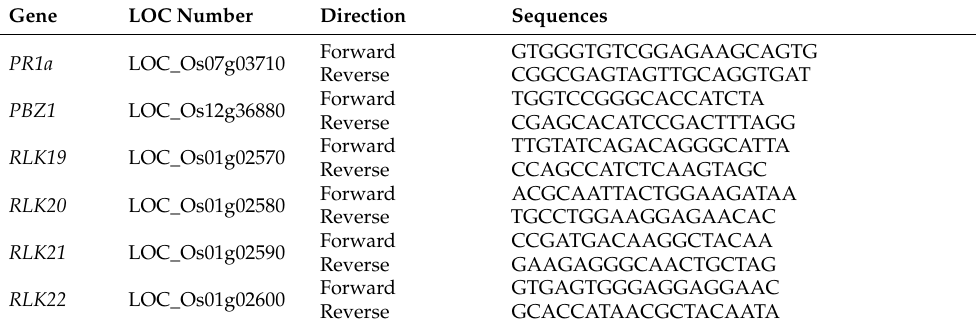
Table 2. Primers used for